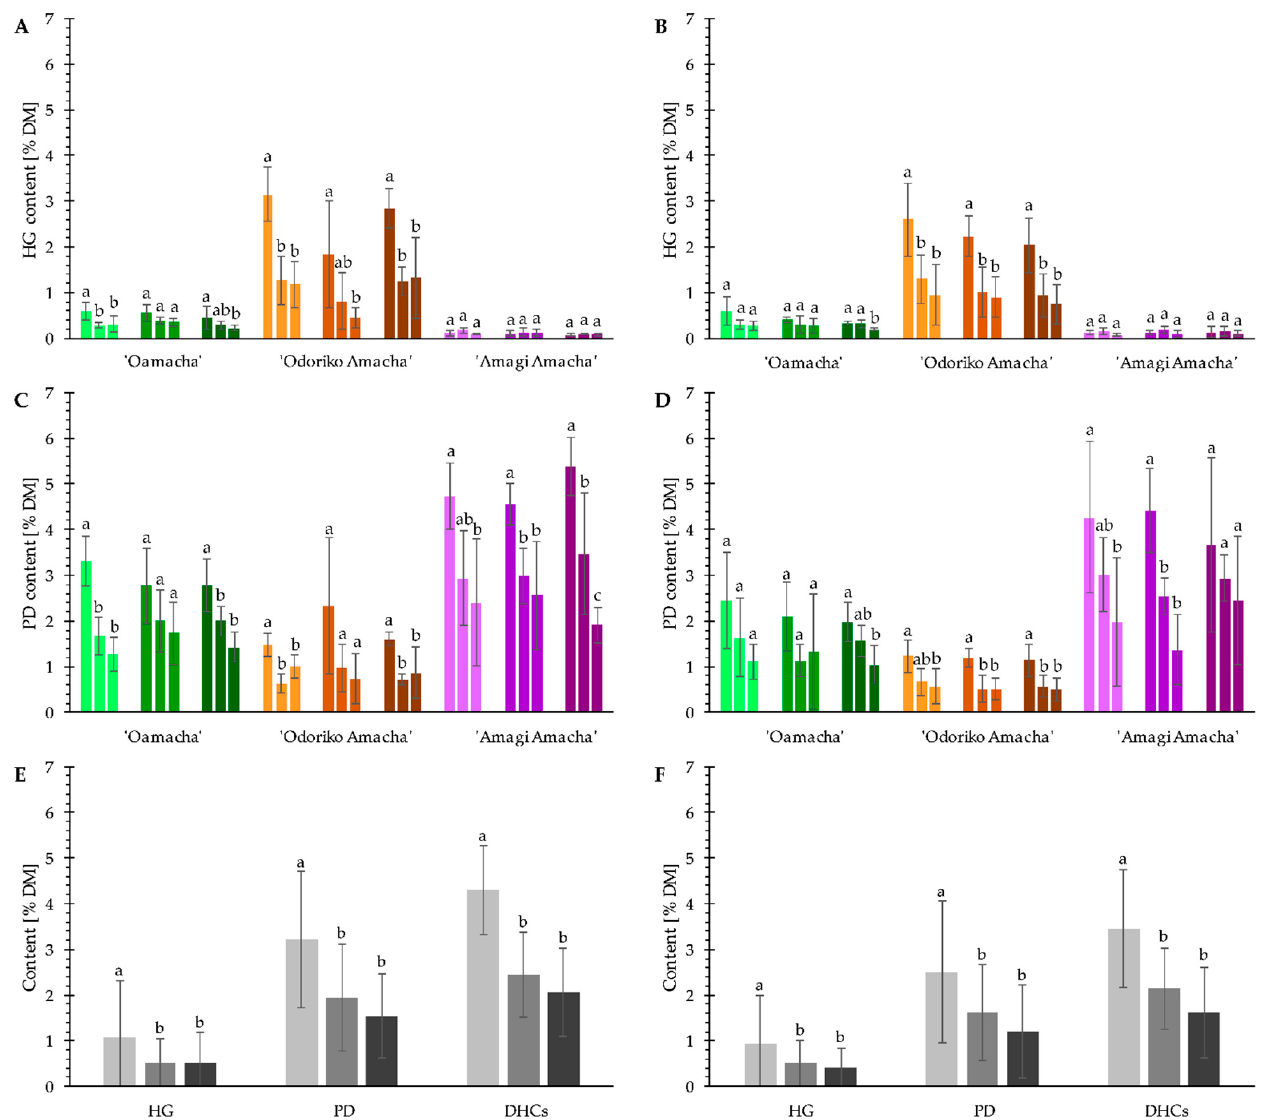
Figure 4. Content (%) of ( A , B ) hydrangenol (HG) and ( C , D ) phyllodulcin (PD) for three H. macrophylla subsp. serrata cultivars (green: ‘Oamacha’, orange: ‘Odoriko Amacha’, purple: ‘Amagi Amacha’) and ( E , F ) for HG, PD and DHC content pooled over all cultivars depending on three shading scenarios in leaf dry matter for two different harvest dates in 2018 (( A , C , E ): 18 September 2018 and ( B , D , F ): 8 October 2018). ( A – D ): Shading scenarios (bright coloring: no shade, light coloring: partial shade, dark coloring: full shade). ( E , F ): Differences for leaf position depending on shading pooled over all cultivars (bright gray: no shade, light gray: partial shade, dark gray: full shade). Significant differences for leaf position (left: upper third, middle: middle third, right: lower third) of each cultivar ( A – D ) or pooled by cultivar ( E – F ) and year calculated by ANOVA and Tukey HSD (n = 5, α = 0.05) are indicated by different letters. Detailed statistical results can be found in the Supplementary Materials for the multivariate analysis (Table S7) and ANOVA tables (Tables S6 and S8).